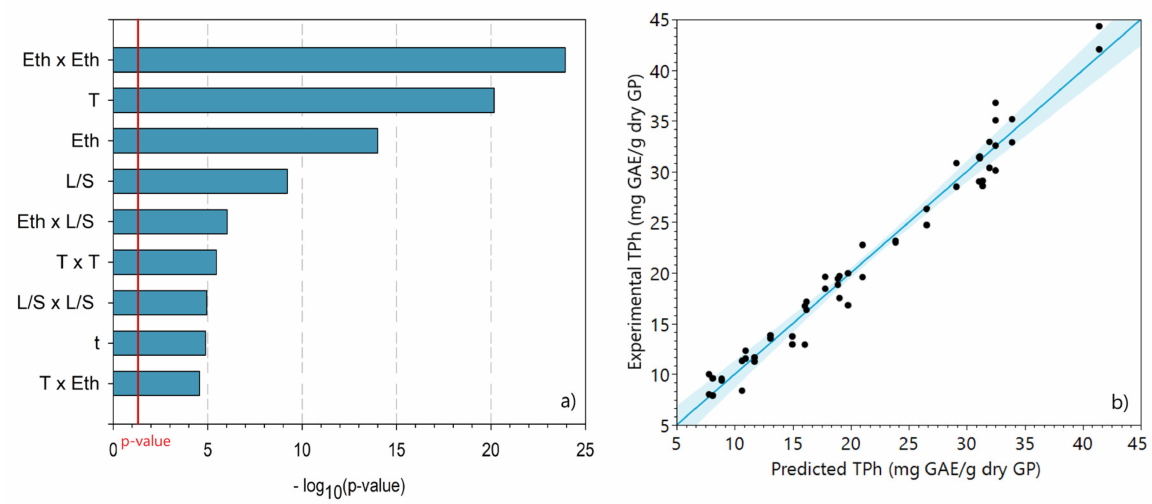
Figure 2. ( a ) Pareto plot of the statistically significant effects of the variables and their interactions for ethanol extraction. ( b ) Comparison between experimental and predicted total phenolic content obtained from the central composite design of